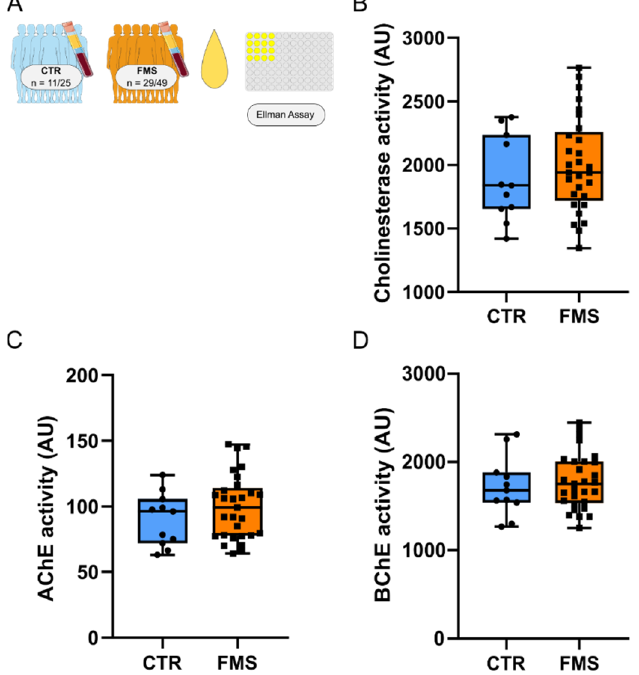
Figure 8. Cholinesterase activity in serum. ( A ) Cohorts and methods. ( B ) Total cholinesterase status in FMS and CTR sera ( p = 0.401) and subdivision in ( C ) AChE-specific activity ( p = 0.256) and ( D ) BChE-specific activity ( p = 0.6224). Mann–Whitney U Test. Abbreviations: AChE, acetylcholinesterase; AU, arbitrary unit; CTR, healthy controls; FMS, fibromyalgia syndrome. Note that there is larger variability in FMS cholinesterase activity compared to that of CTR.